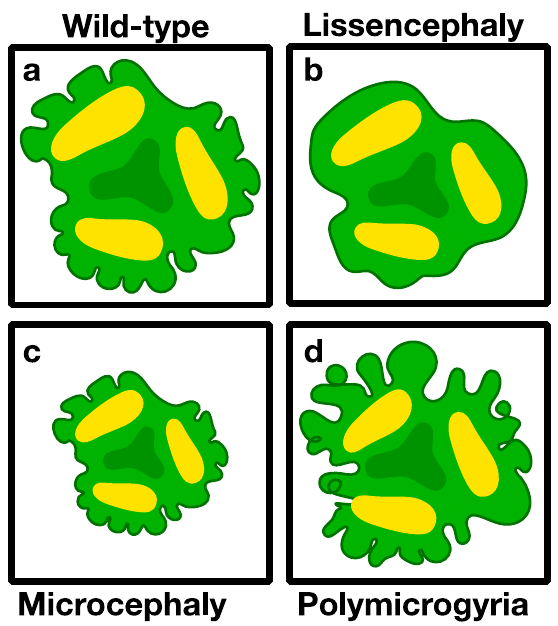
Figure 2. Schematic presentation of brain malformations that can be modeled in brain organoids. ( a ) Normal brain organoids ( b ) lissencephaly (smooth brain) ( c ) microcephaly (small brain), and ( d ) polymicrogyria (extra brain folds).